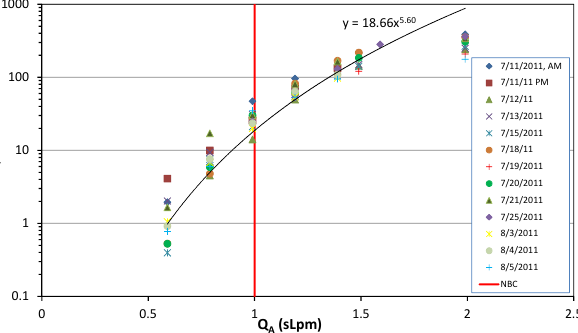
Fig. 2. Particle count rates plotted versus flow through the sulfuric acid reservoir, RH at 27%, T = 296K. NBC is Q A = 1sLpm and N r shows a variability of a factor of ∼ 2 ( × 2, ÷ 2) over weeks. A typical power dependency is shown for these conditions.